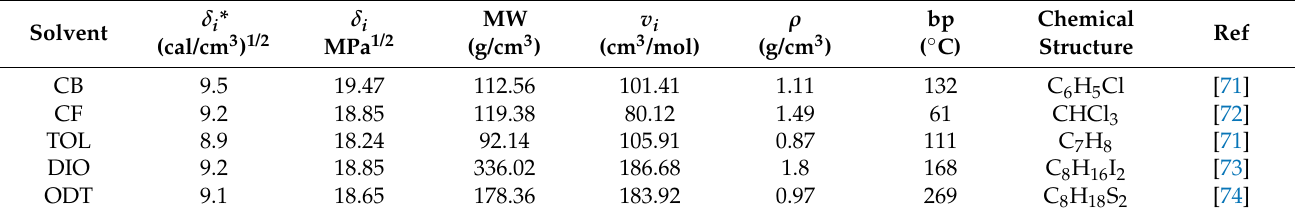
Figure 1. Chemical structures of ( a ) electron-donating conjugated polymers, ( b ) electron-accepting small molecules, ( c ) solvents, and ( d ) processing additives. Table 2. Solubility parameter ( δ i ), molecular weight (MW), molar volume ( v i ), density ( ρ ), boiling point (bp), chemical structure, and reference for solvents and processing